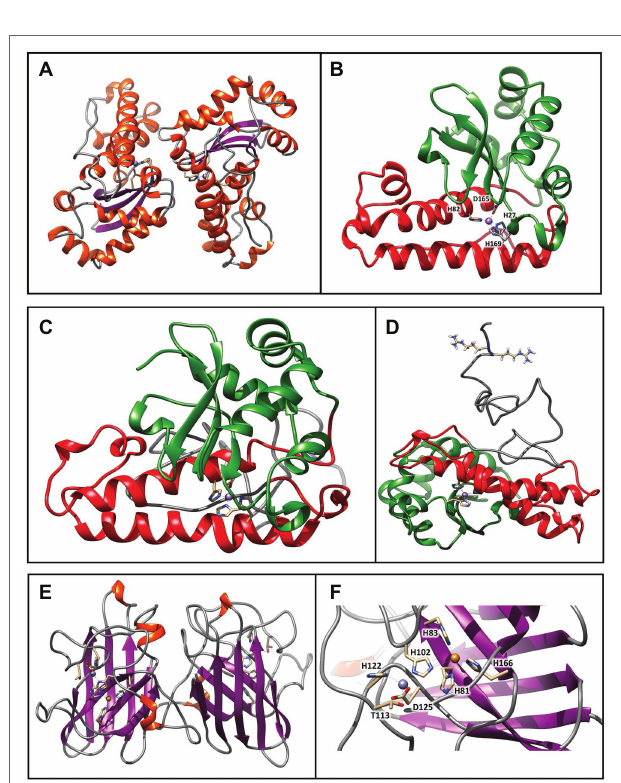
FIGURE 4 | Molecular models of SODs from Chroococcidiopsis sp. CCMEE 029. (A) Model of the SodA2.2 dimer generated using as a template the crystal structure of MnSOD from Nostoc sp. PCC 7120 (PDB ID: 1GV3). The β -strands are represented by violet arrows, while the α -helices and the loops are shown as orange spirals and light gray wires, respectively. (B) The red and green colors indicate the N-terminal helical hairpin domain and the C-terminal α / β domain. The metal binding site is shown in stick representation. (C) Model of the sodA2.1 generated by the I-TASSER structure prediction algorithm. The red and green colors indicate the N-terminal helical hairpin domain and the C-terminal α / β domain typical of bacterial MnSOD. (D) The unstructured N-terminal region (gray wire) holds the two sequential arginines required for the interaction with the TatC receptor. The metal-binding site and the arginines are shown in stick representation. (E) Model of the SodC dimer generated using as a template the crystal structure of Cu/ZnSOD from Caenorhabditis elegans sp. (PDB ID: 3KBF). The β -strands are represented by violet arrows, while the α -helices and the loops are shown as orange spirals and light gray wires, respectively. (F) The copper (orange atom) and zinc (plum atom) binding sites are shown in stick representation. These images were generated using the Chimera